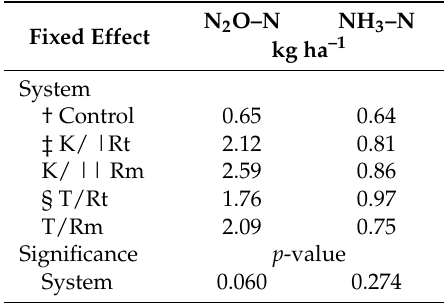
Table 5. Treatment means and significance of N emission over the entire sampling